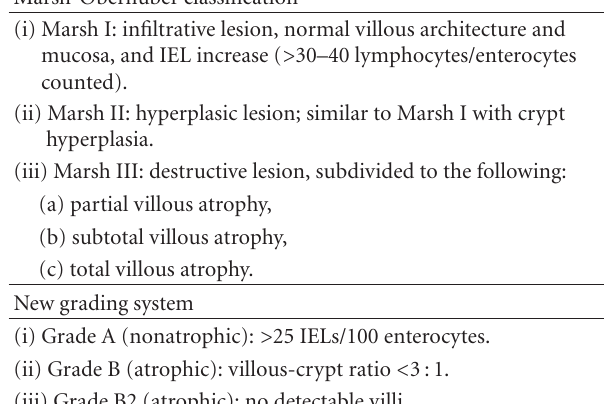
Table 4: Histopathologic classification of CD based on Marsh- Oberhuber [56, 57], and Corazza and Villanacci [58] new grading system [12, 57,